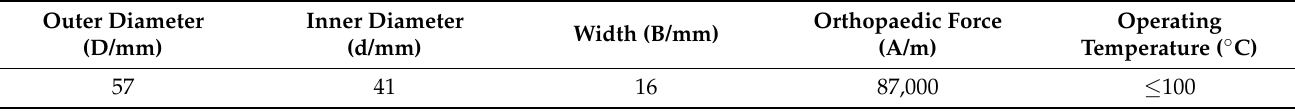
Figure 3. Magnetic fluid lubricated bearing structure. Table 2. Basic parameters of permanent magnet